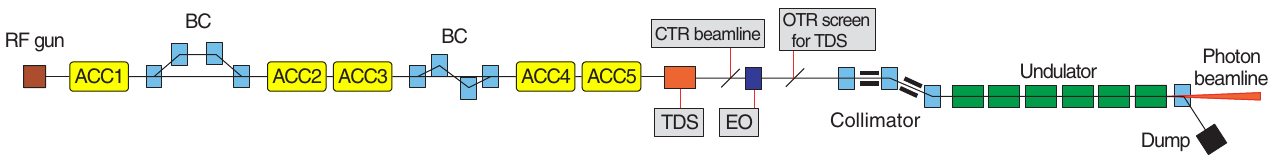
FIG. 1. (Color) Schematic view of the free-electron laser facility FLASH. The electron bunches are generated in a laser-driven photocathode that is mounted inside a 1.3 GHz copper cavity for rapid acceleration to 4–5 MeV. The particle energy is raised to 400– 770 MeV in five acceleration modules (ACC1-ACC5), each containing eight superconducting cavities. Two magnetic chicanes are used for longitudinal bunch compression (BC). The diagnostic section comprises a transverse-deflecting radio-frequency structure (TDS), a beam line for coherent transition radiation (CTR) spectroscopy, and the electro-optic setup (EO) used in the present